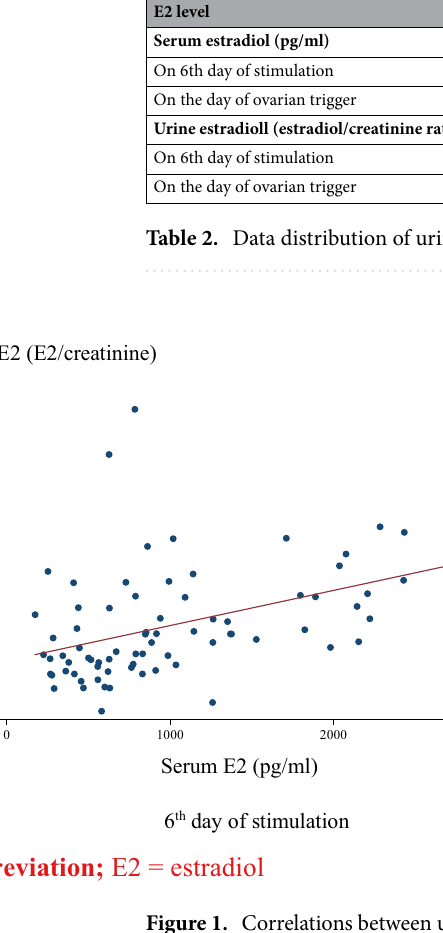
Figure 1. Correlations between urine and serum E2 concentration on 6th day of stimulation and day of ovarian trigger. E2 estradiol.